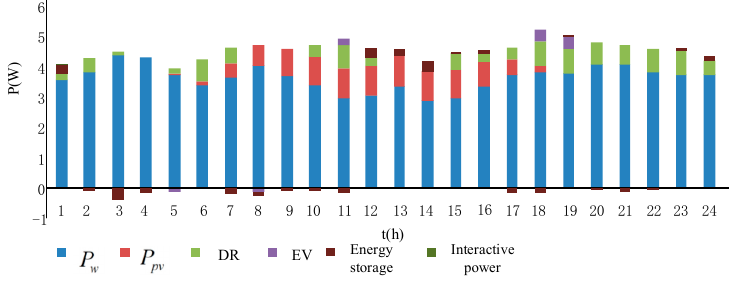
Figure 7. Optimized scheduling scheme for accessing EV.